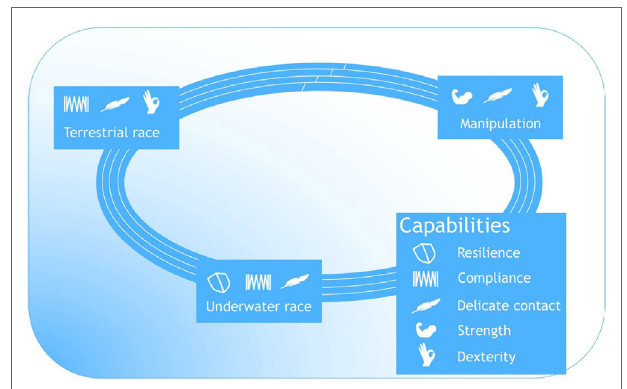
FIGURe 1 | the Robosoft Grand Challenge aims to highlighting soft robots capabilities together with traditional ones